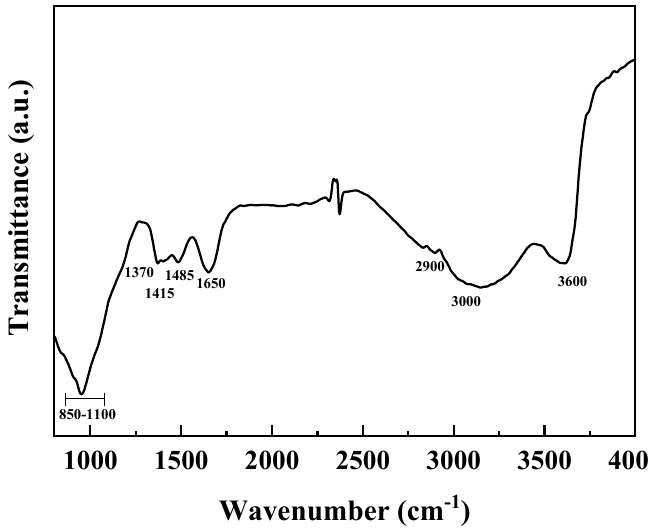
Figure 5. Thermogravimetric (TG) and Derivative Thermogravimetric (DTG) curves of paste after 28 days of curing.